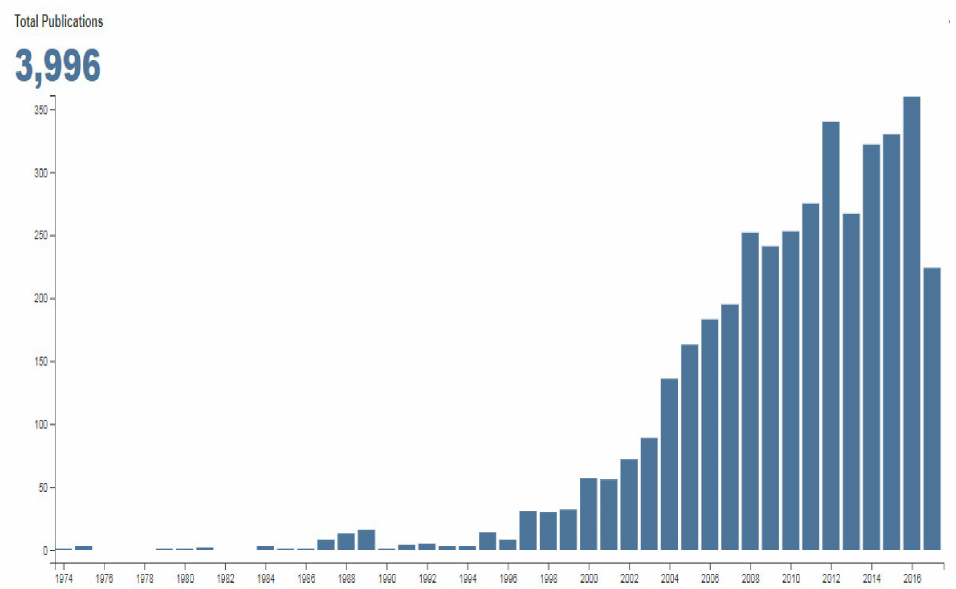
Figure 5. Growth in number of publications of micro-channels [77] © Elsevier,